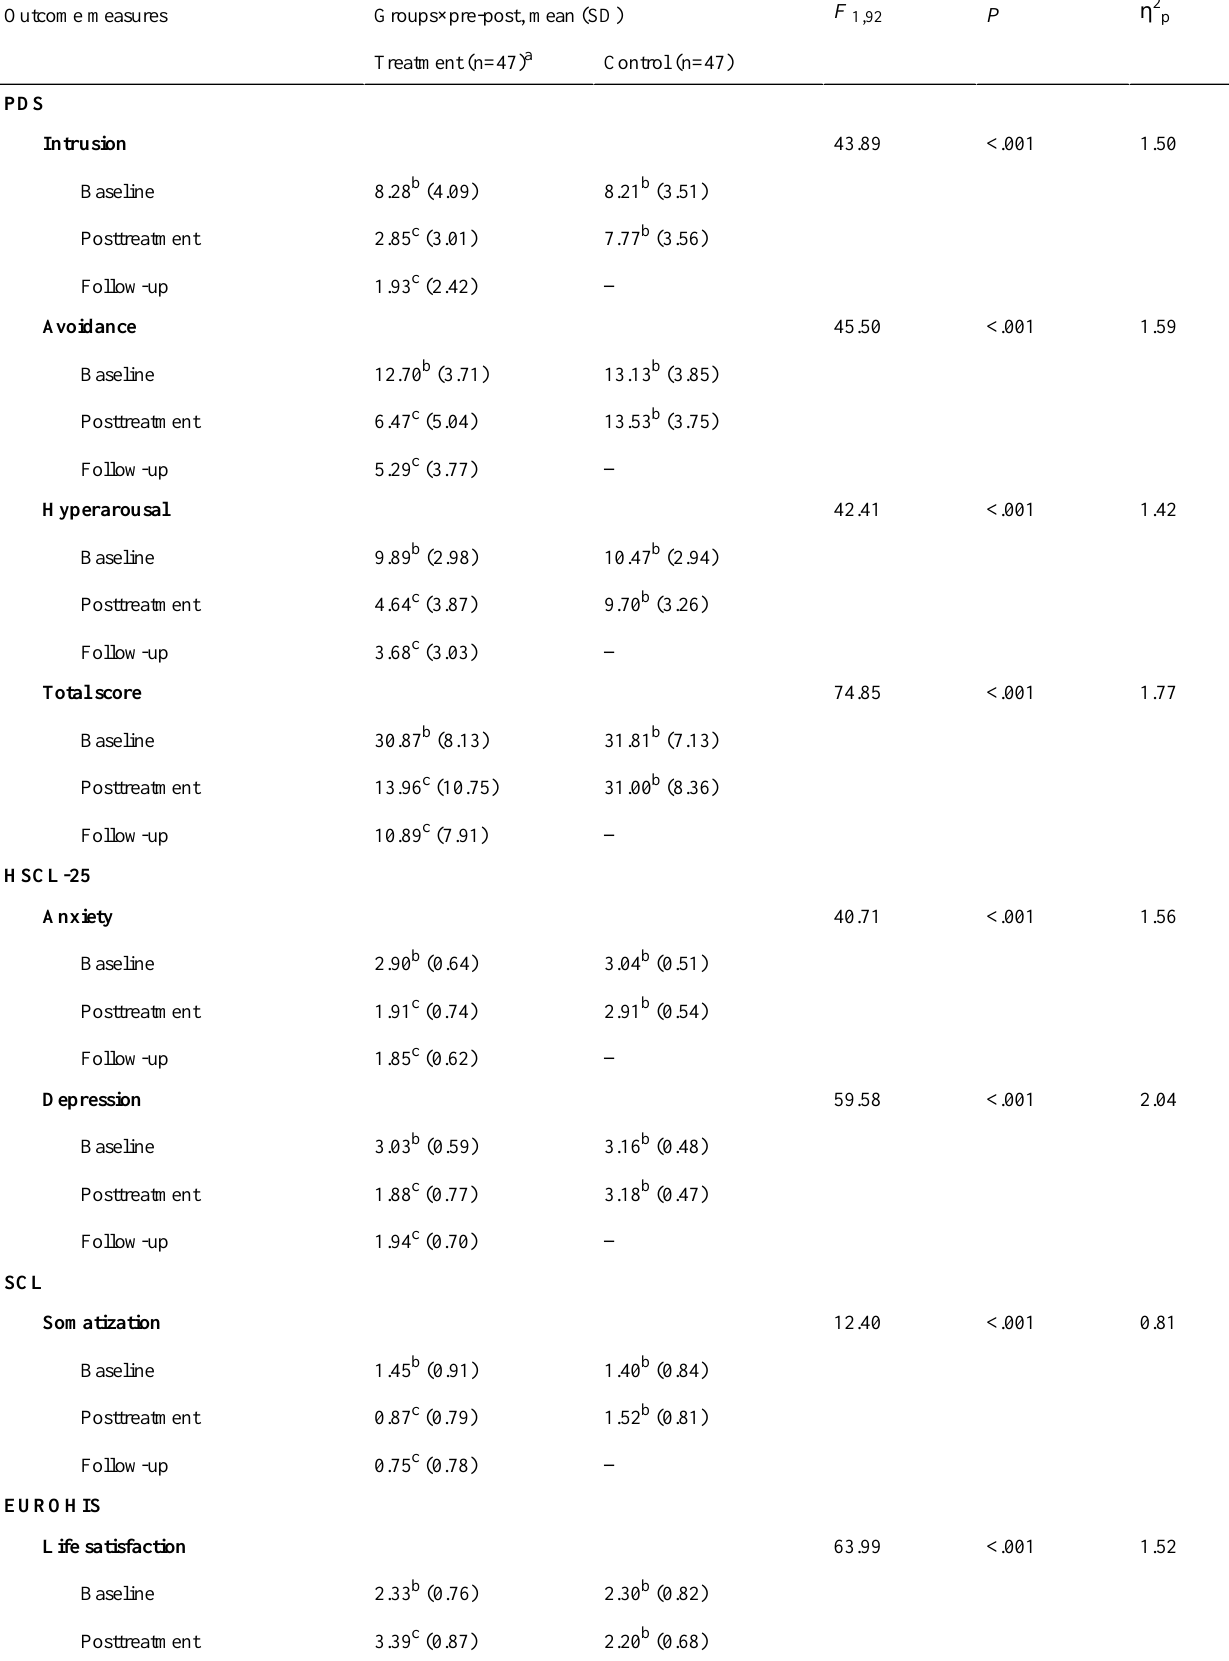
Table 3. Results of mixed design ANOVAs for the treatment and waiting list control groups at baseline, posttreatment, and 3-month follow-up: completer